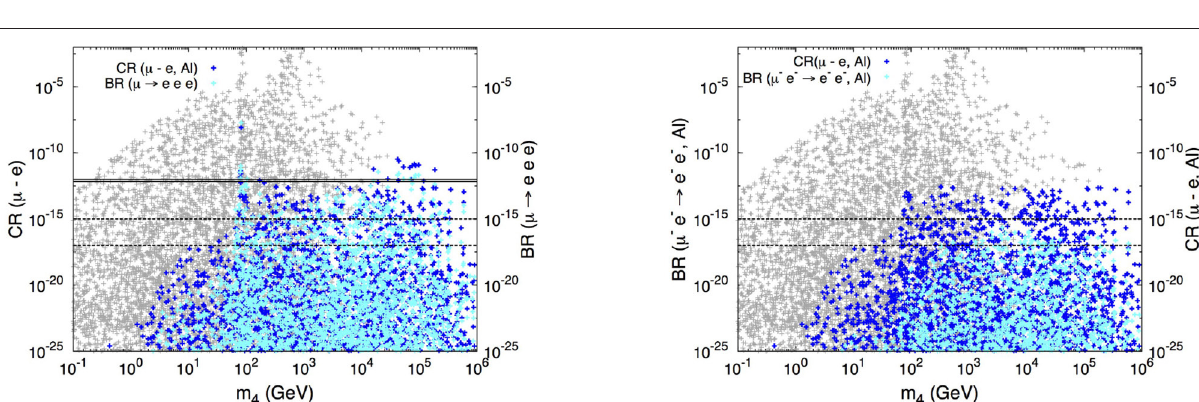
FIGURE 3 | On the (left) , predictions for CR( µ in cyan (right axis). A thick (thin) solid horizontal line denotes the current experimental bound on the CR( µ correspond to future sensitivities to CR( µ of m 4 ; dashed horizontal lines denote the (expected) future sensitivity of COMET to both observables. Both figures were obtained in the “3+1” model, and in both panels gray points correspond to the violation of at least one experimental bound (from [42], reproduced with permission from the